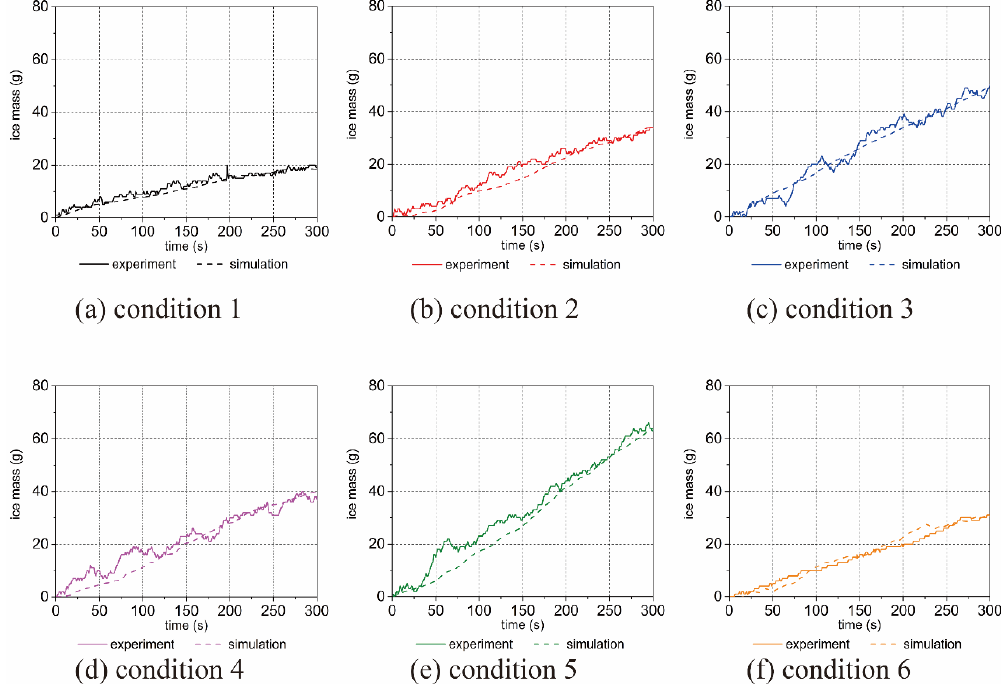
Figure 6. Comparison of ice accumulation in the experiment and simulation in ( a ) condition 1, ( b ) condition 2, ( c ) condition 3, ( d ) condition 4, ( e ) condition 5, and ( f ) condition 6.